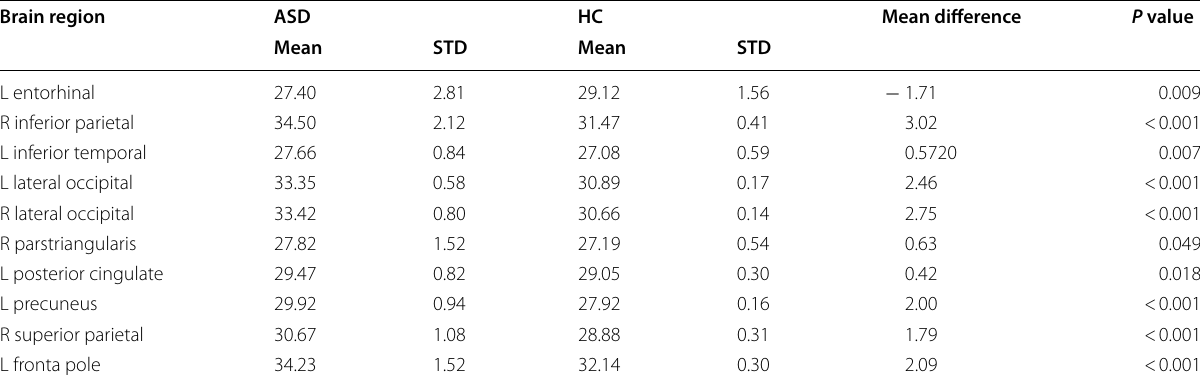
ASD Autism Spectrum Disorder, HC Healthy Controls, STD Standard Deviation, L Left, R Right